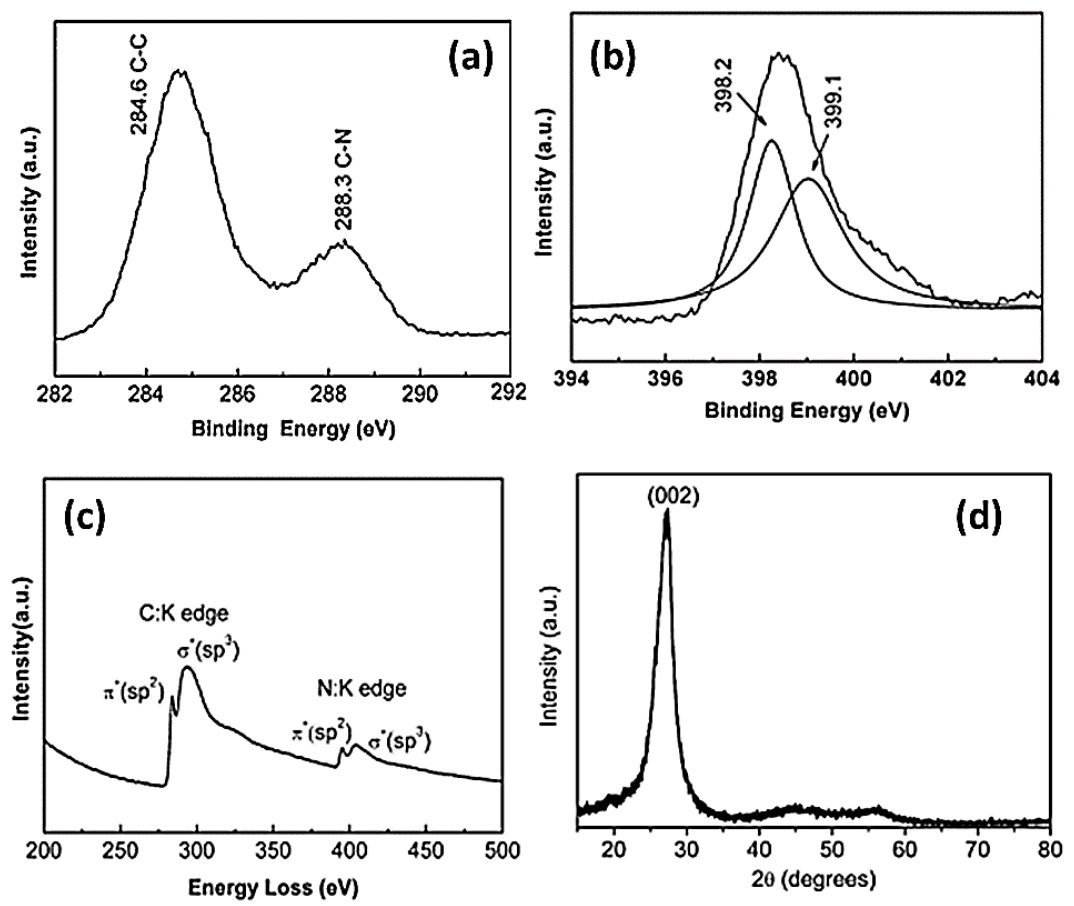
Figure 3. Elemental analysis of the g-C 3 N 4 ; ( a ) C1s XPS peaks of g-C 3 N 4 ; ( b ) N1s XPS peaks of g- C 3 N 4 ; ( c ) electron energy loss spectroscopy spectrum; ( d ) a characteristic XRD spectra of g-C 3 N 4